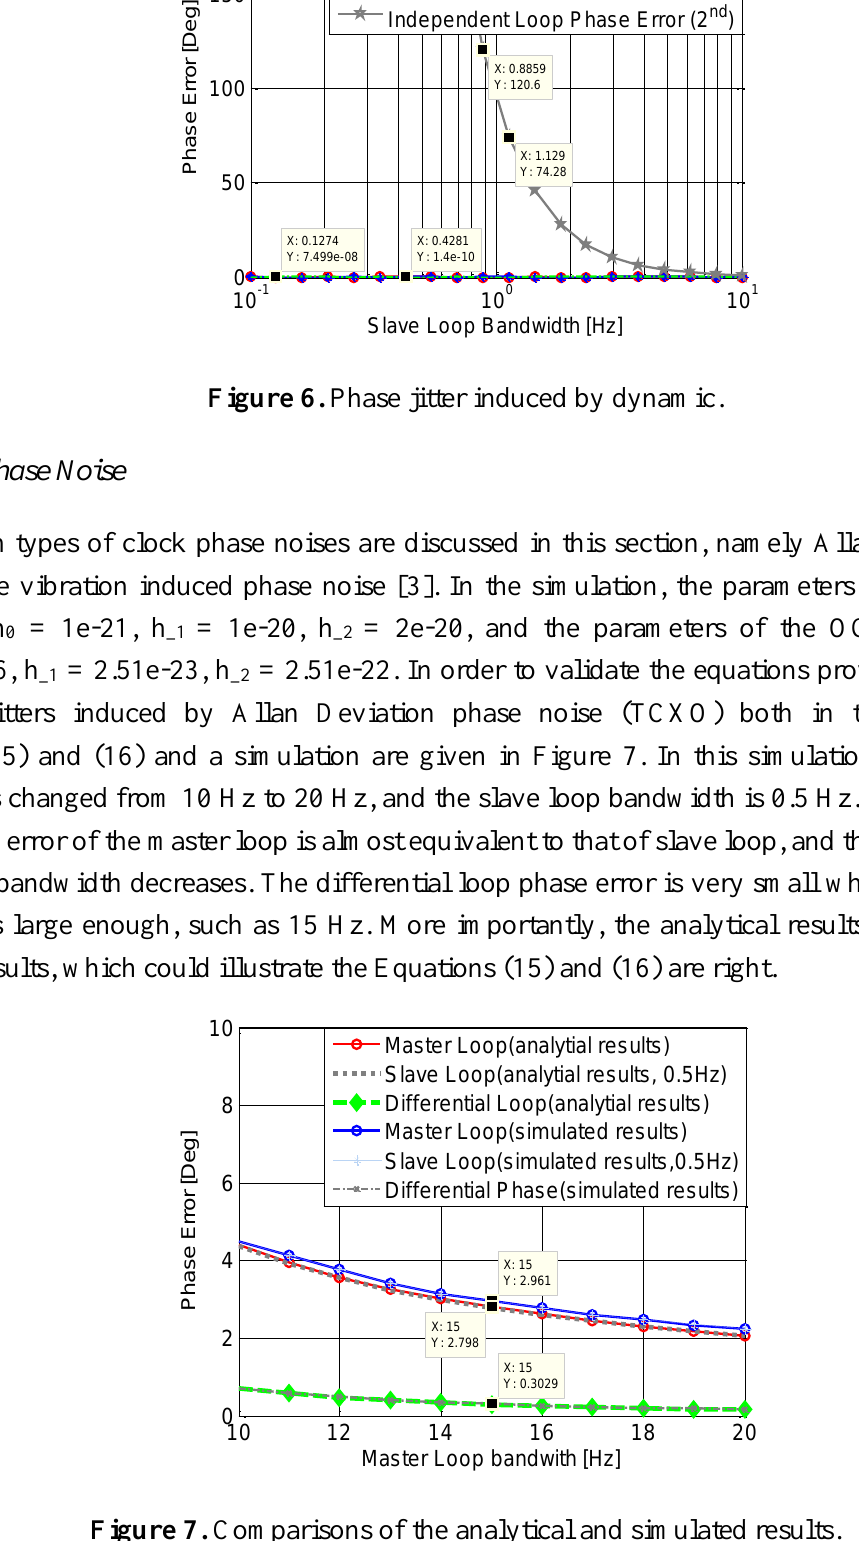
Figure 7. Comparisons of the analytical and simulated